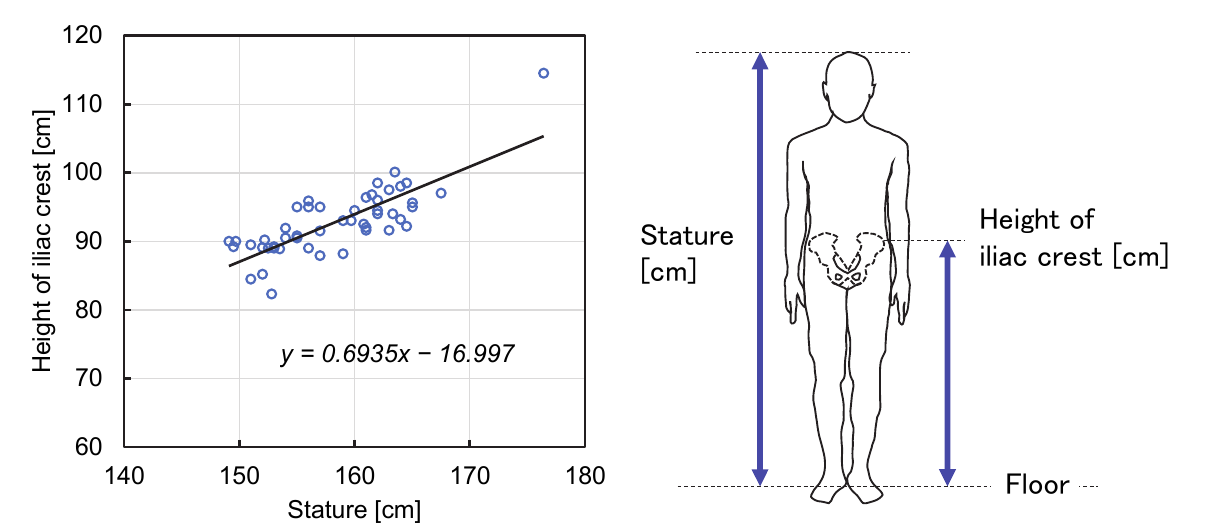
Figure 2. Stature and superior iliac crest height relationship for female participants. The two values are proportional.